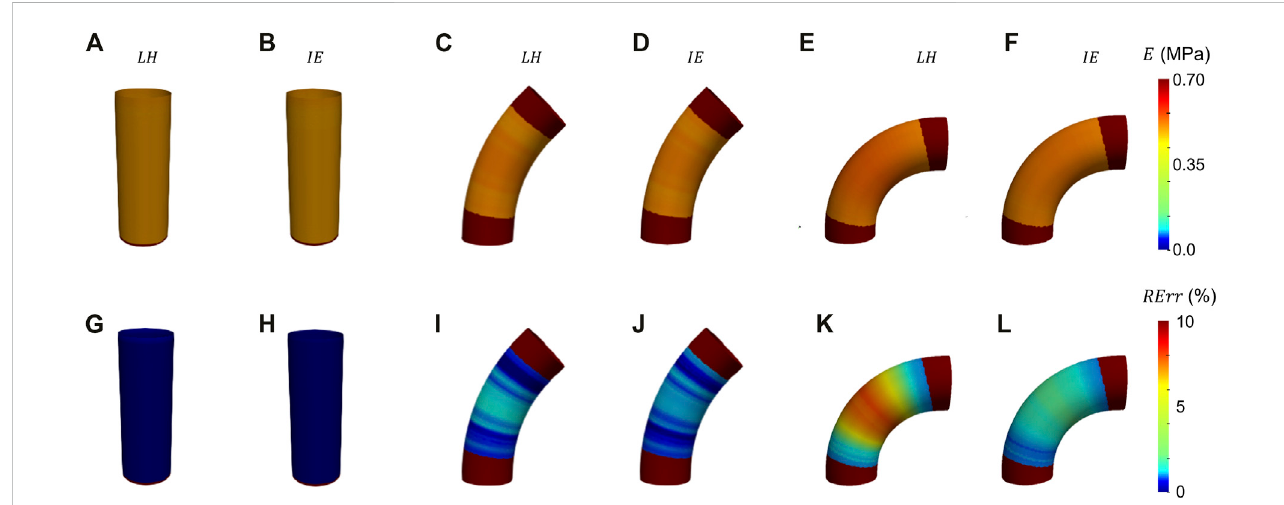
FIGURE 5 Young ’ smodulusmapsofFEvalidationforidealizedgeometries (A – F) withcorrespondingrelativeerrors (G − I) .ThemapsarepresentedforbothLH (A,G, C, I, E, K) and IE ( B, H, D, J, F, L ) methods.